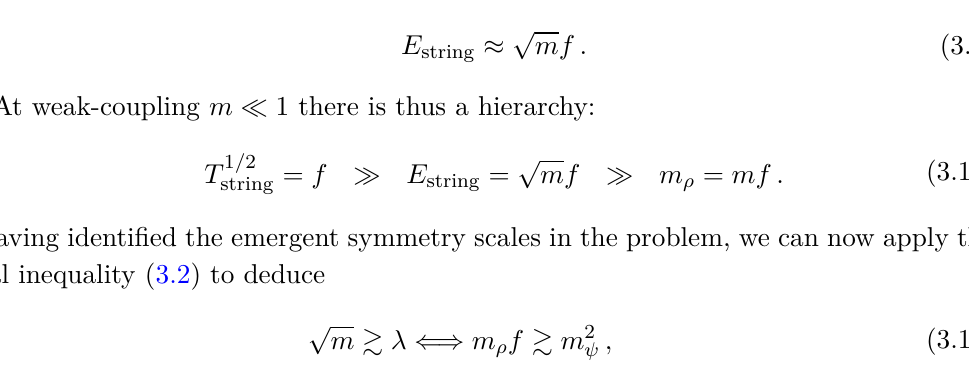
√ mf (cid:29) mf . The